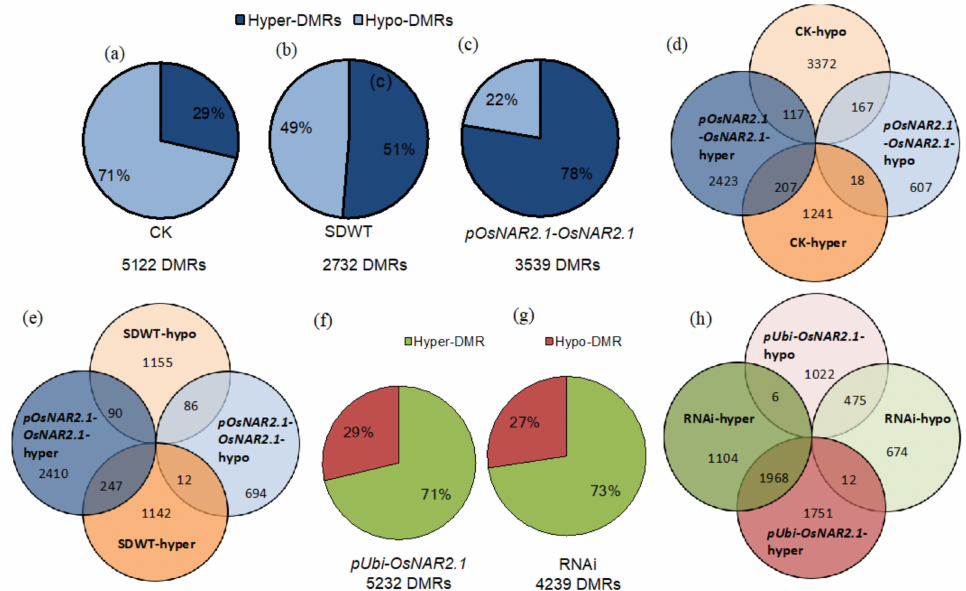
Figure 2. Characteristics of DMRs. ( a - c ) Total number of DMRs and breakdown of hyper- and hypo-DMRs in CK, SDWT and pOsNAR2.1-OsNAR2.1 samples. ( d ) Venn diagram of unique and shared hyper- and hypo-DMRs in pOsNAR2.1-OsNAR2.1 and CK samples. ( e ) Venn diagram of unique and shared hyper- and hypo-DMRs in pOsNAR2.1-OsNAR2.1 and SDWT samples. ( f , g ) Total number of DMRs and breakdown of hyper- and hypo-DMRs in pUbi-OsNAR2.1 and RNAi samples. ( h ) Venn diagram of unique and shared hyper- and hypo-DMRs in pUbi-OsNAR2.1 and RNAi